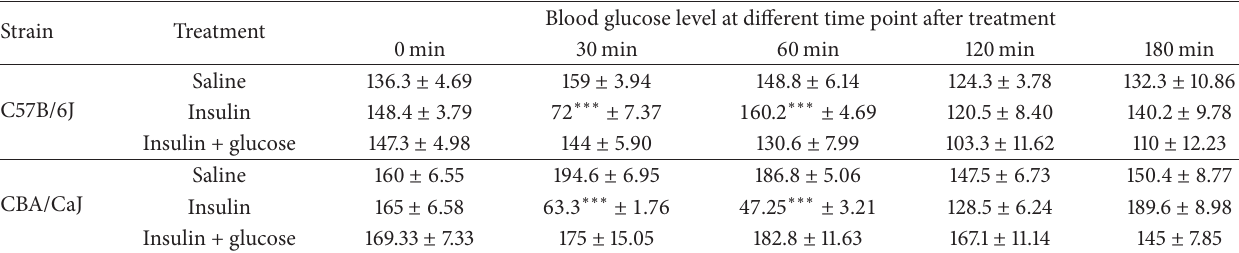
Table 1: Summary of blood glucose levels in different situation.